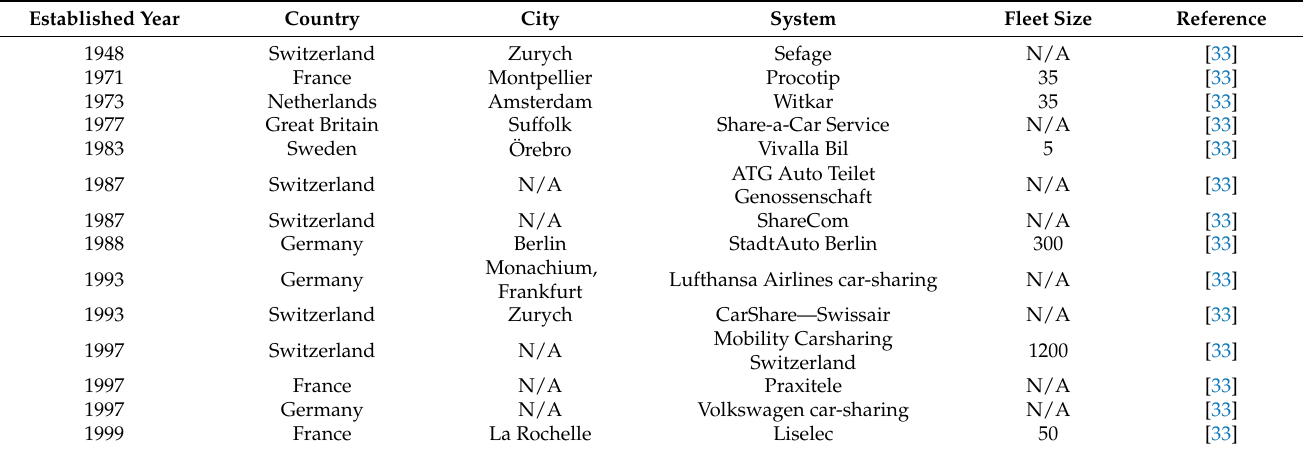
Table 1. List of selected car-sharing systems operating in Europe in